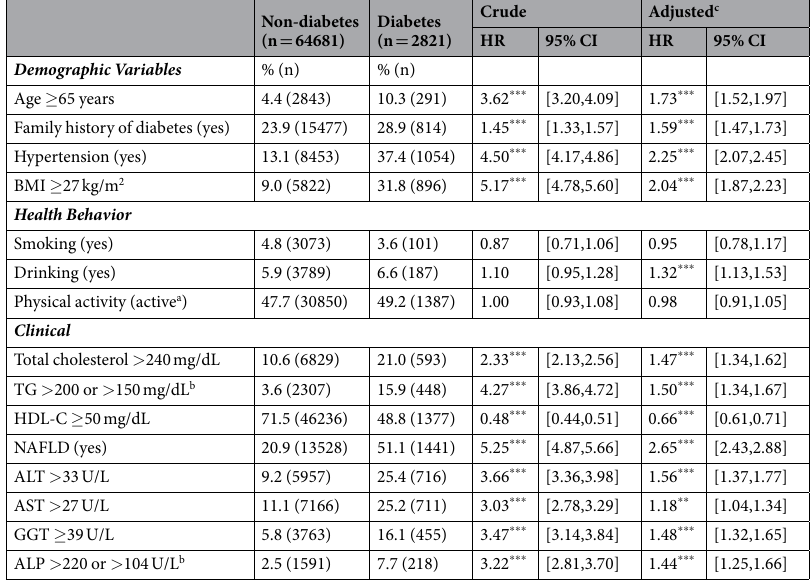
Table 3. Cox regression analysis of type 2 diabetes in women. The values were described as frequency (n). * p < 0.05, ** p < 0.01, *** p < 0.001. 95% CI in brackets. Abbreviations: FPG, fasting plasma glucose; TG, triglycerides; HDL-C, high-density lipoprotein cholesterol; NAFLD, non alcoholic fatty acid disease; ALT, alanine transaminase; AST, aspartate transaminase; GGT, gamma-glutamyltransferase; ALP,